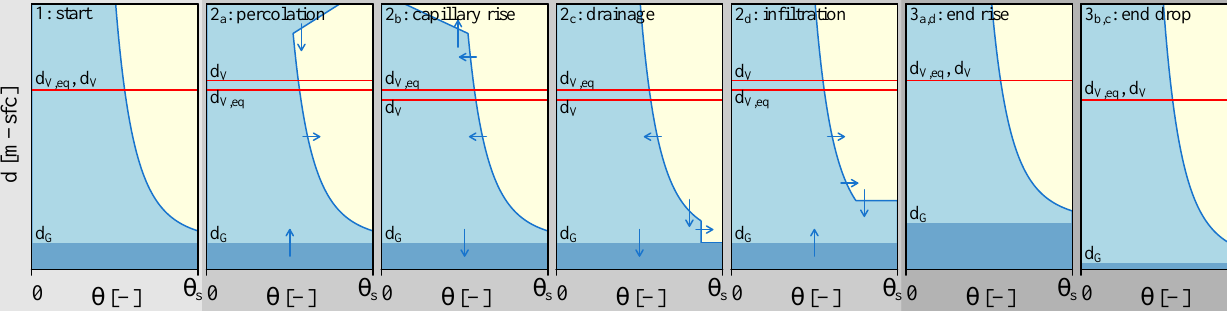
Figure 8. Illustration of the four scenarios for change in groundwater levels: (a) percolation after rainfall, (b) capillary rise after evapotran- spiration, (c) percolation after drainage and (d) capillary rise after infiltration. WALRUS only simulates the solid lines of d G , d V and d V,eq rather than the profiles of relative saturation (dashed). The areas right of the curves (the integral of (θ s − θ) over d ) is equal to the values of d V